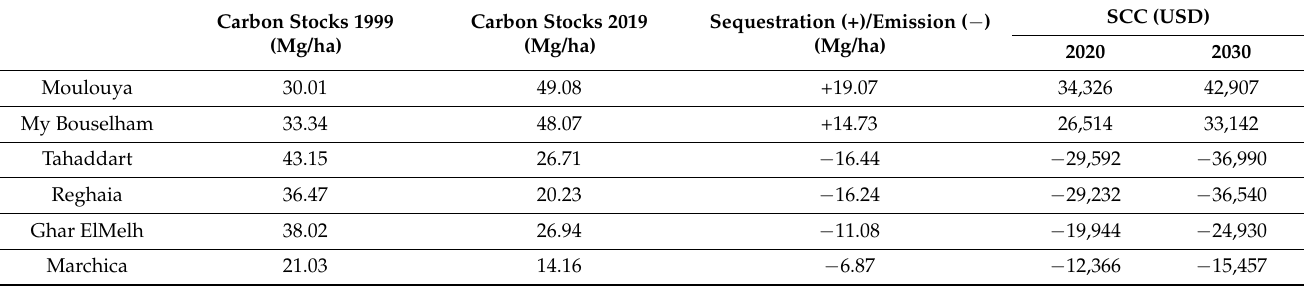
Figure 10. Wetlands carbon stock. ( A ) Moulay Bousselham carbon stock of 1999;( B ) Moulay Bousselham carbon stock of 2019; ( C ) Tahaddart carbon stock of 1999; ( D ) Tahaddart carbon stock of 2019; ( E ) Marchica carbon stock of 1999; ( F ) Marchica carbon stock of 2019; ( G ) Moulouya carbon stock of 1999; ( H ) Moulouya carbon stock of 2019; ( I ) Reghaia carbon stock of 1999; ( J ) Reghaia carbon stock of 2019; ( K ) Ghar El Melh carbon stock of 1999; ( L ) Ghar El Melh carbon stock of 2019. Table 3. Economic value of the carbon sequestrated or